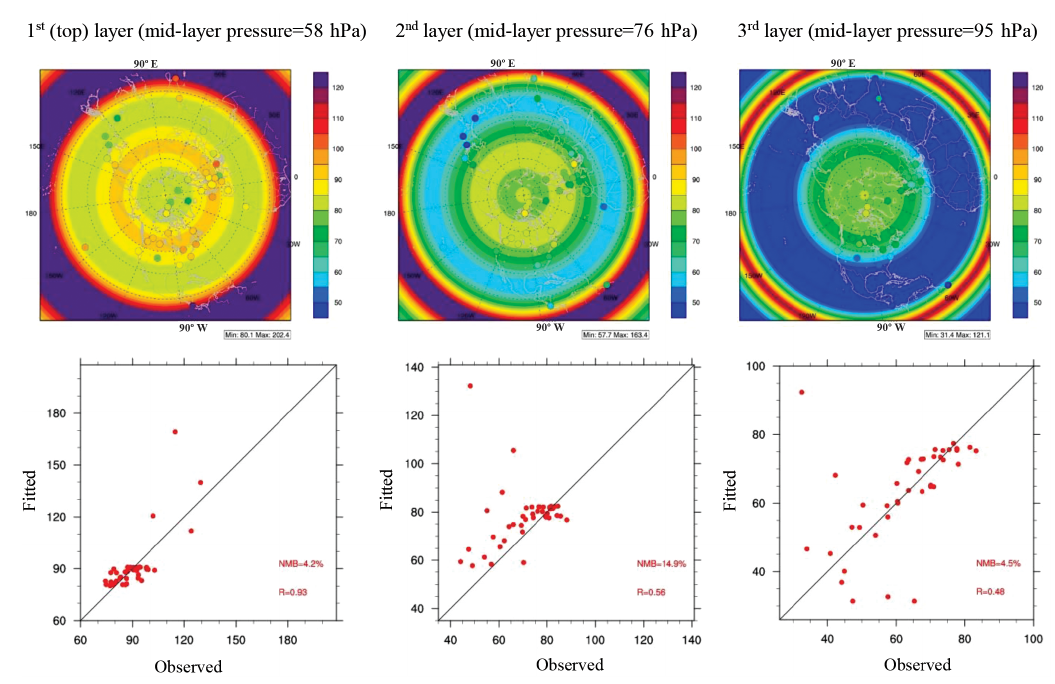
Figure 2. Sensitivity of O 3 / PV to spatial location (ppbPVu − 1 ).